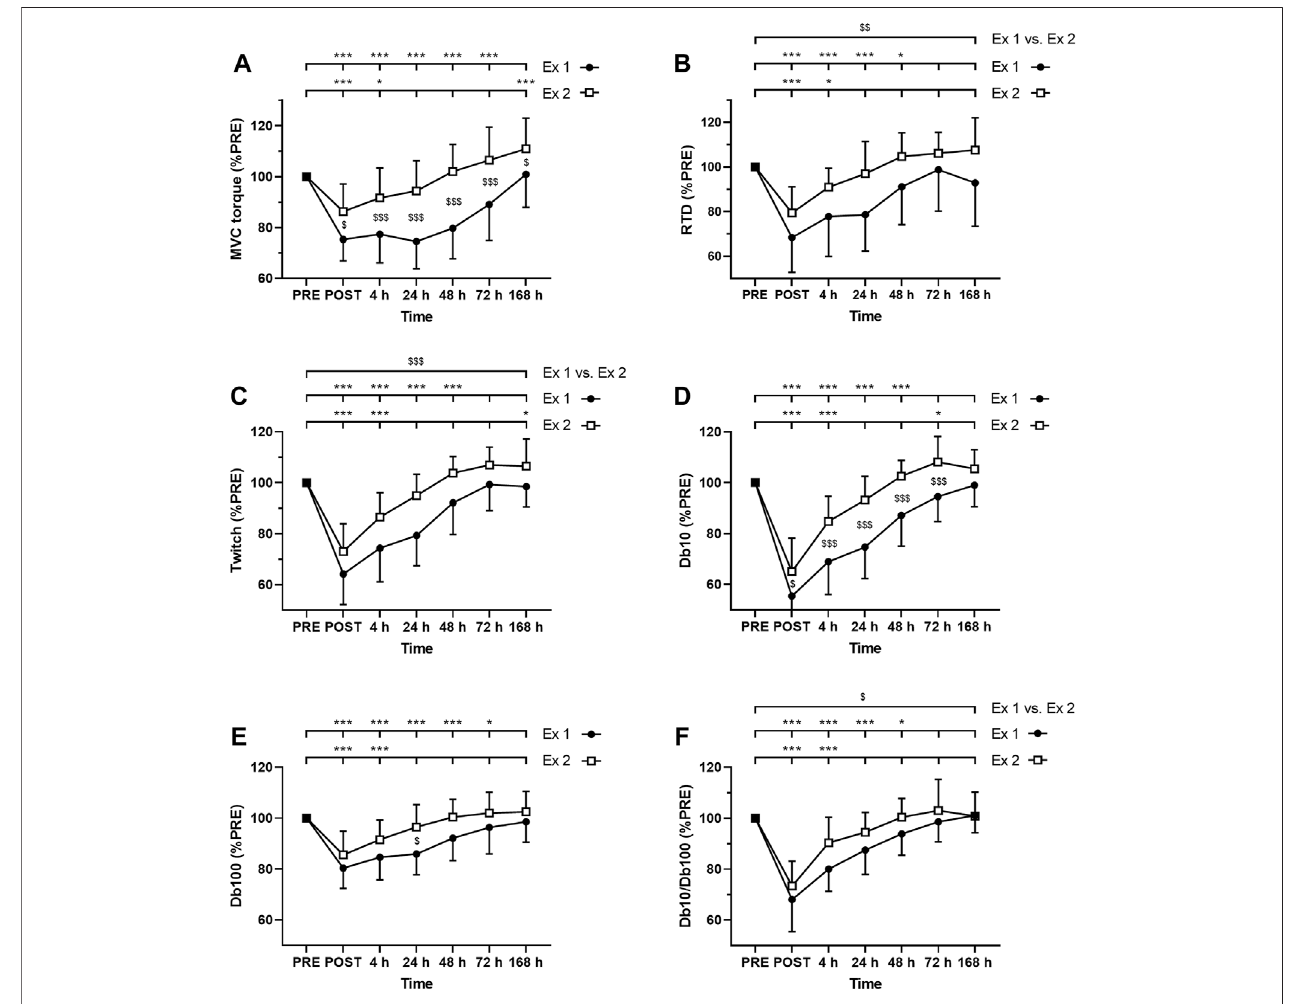
FIGURE 3 | Time course of (A) maximal voluntary contraction (MVC) torque (B) rate of torque development (C) twitch amplitude (D) amplitude of the doublet at 10 Hz (Db10) (E) amplitude of the doublet at 100 Hz (Db100) and (F) Db10 Hz-to-Db100 Hz ratio (Db10/Db100). *, ** and *** correspond to signi fi cant difference from PRE value at p < 0.05, p < 0.01 and p < 0.001, respectively. $, $$ and $$$ correspond to signi fi cant difference between exercise 1 and exercise 2 at p < 0.05, p < 0.01 and p < 0.001,